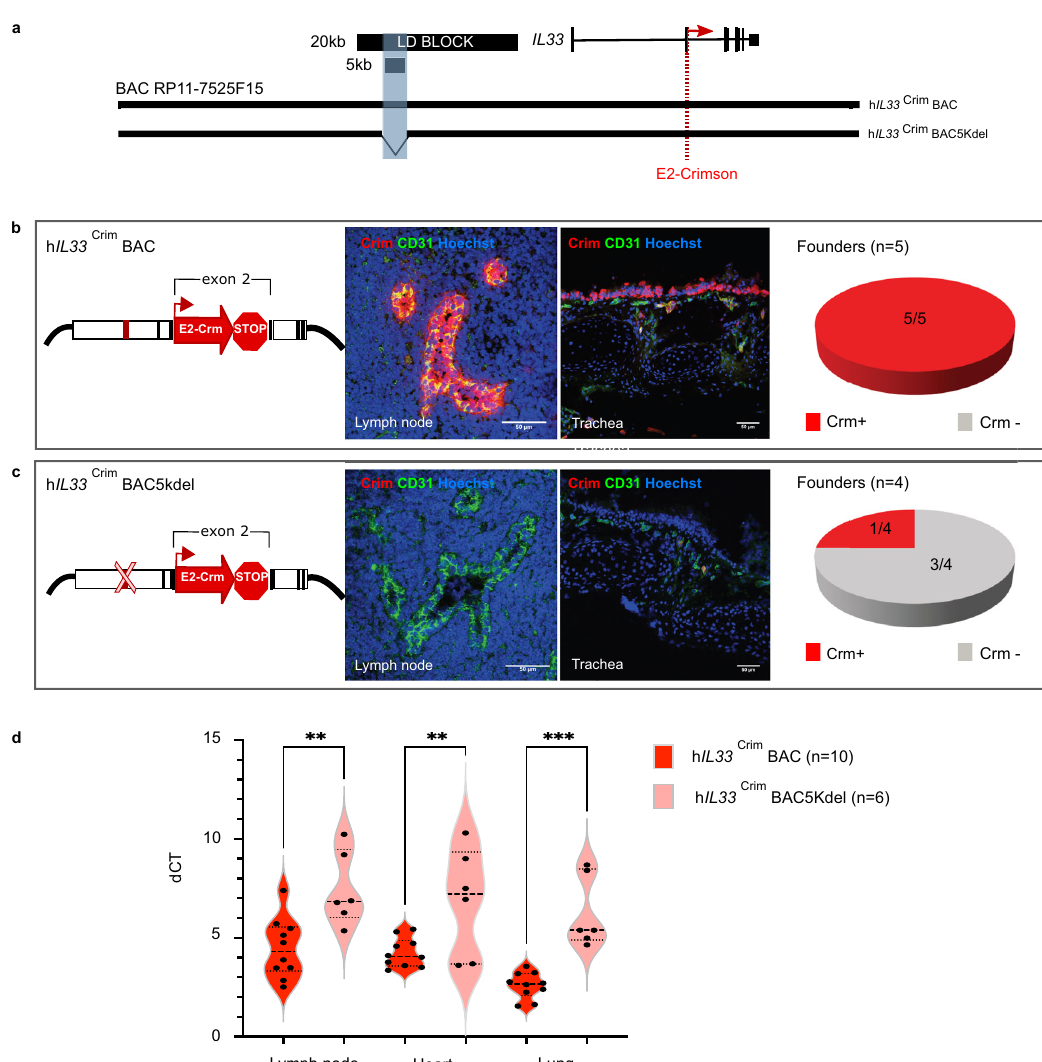
Fig. 2 The IL33-containing BAC in transgenic mice encodes human-speci fi c regulatory patterns and demonstrates the importance of the 5 kb noncoding segment for proper IL33 expression. a Schematic of human BAC clone RP11-725F15 (166 kb) spanning the entire coding region of IL33 and its upstream region including the 20 kb asthma-associated interval and the 5 kb region of interest shaded in blue (black bars). To produce a human IL33 reporter strain, a cassette containing E2-Crimson with a stop sequence was inserted into exon 2, in frame with the IL33 translational start site (red dotted line). Transgenic mice were generated with either the full BAC (h IL33 Crim BAC) or a BAC containing a deletion of the 5 kb interval within the LD block (h IL 33 Crim BAC5kdel). b , c Immuno fl uorescence staining of mouse peripheral lymph node sections (left panels) and trachea tissue sections (right panels) of E2-Crimson in h IL33 Crim BAC mice ( b ) or h IL33 Crim BAC5kdel ( c ). Representative founder BAC transgenic lines are shown. Sections were stained with anti-E2-Crimson (red) and the mouse endothelial cell marker CD31 (green). Hoechst 33342 staining for nuclei is in blue. Pie charts show the distribution of Crimson expression (Crm) in each “ humanized ” BAC mouse line. d qPCR analysis of E2-Crimson mRNA obtained from lymph node, heart, and lung from both BAC strains is shown. Violin plot shows average dCT values (Crimson/Ppia) obtained from animals containing either the full BAC or the 5 kb deletion ( n = 10 biologically independent animals for full BAC and n = 6 biologically independent animals for 5 kb deletion). Center line: median; box limits: upper and lower quartiles; whiskers: 1.5 × interquartile range. ** p = 0.0017 (lymph node); ** p = 0.0066 (heart), ***0.0001; one-way ANOVA with post hoc Sidak multiple comparison test. Source data are provided as a Source Data fi